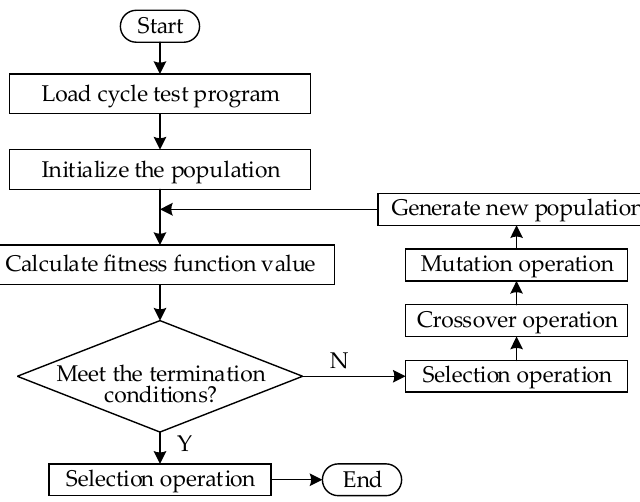
Figure 5. Flow chart of transmission speed ratio optimization by genetic algorithm. During the optimization process, the fitness function value is calculated each time using the steps shown in Figure 6.